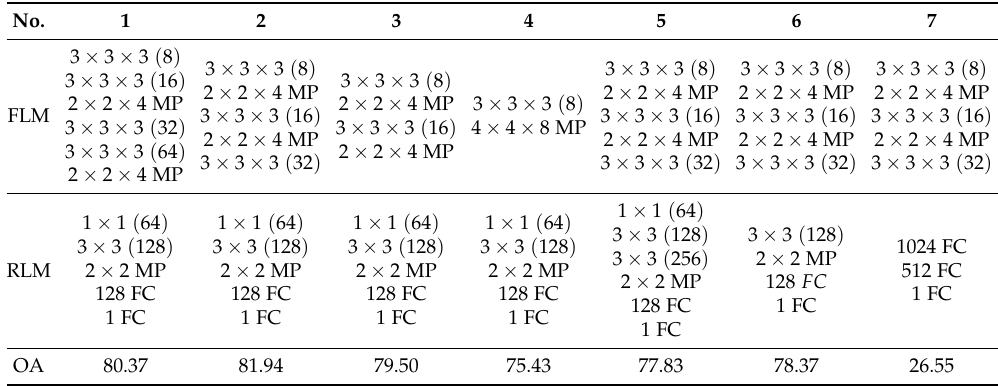
Table 6. Overall classification accuracy (OA, %) on the UP data set under different network structure settings. The feature learning module (FLM), the relation learning module (RLM), max pooling (MP), fully connected layer